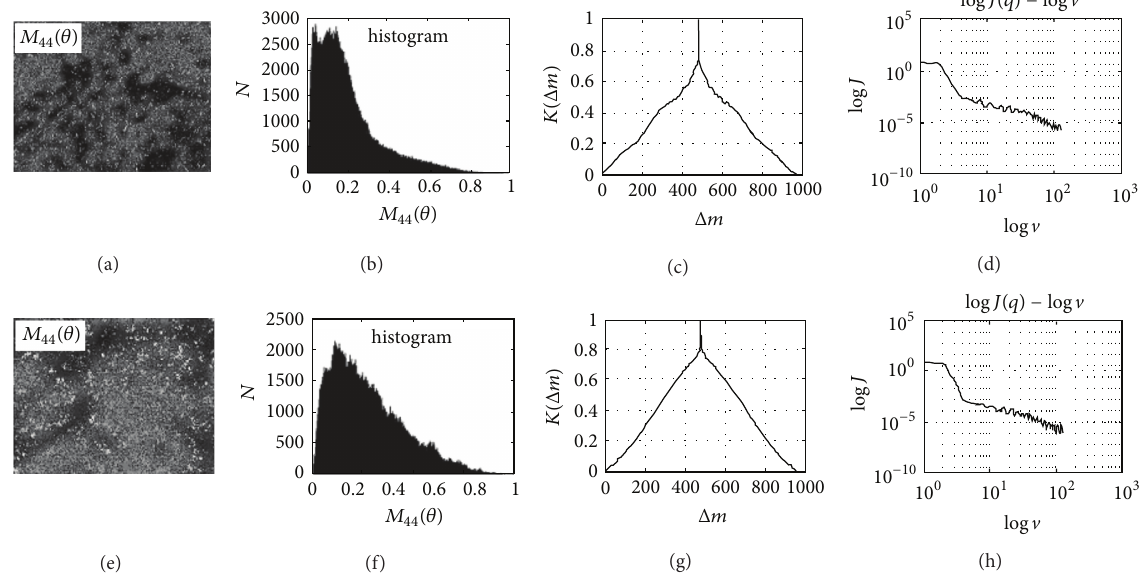
Figure 4: “High-frequency” coordinate maps 𝑀 44 (𝜃) (a), (e) histograms (b), (f) autocorrelation functions (c), (g) logarithmic dependence of the power spectra (d), (h) of the linear birefringence distribution of a histological section of benign uterine tumor (fibromyoma) biopsy ((a)–(d)), and malignant uterine tumor (adenocarcinoma) biopsy